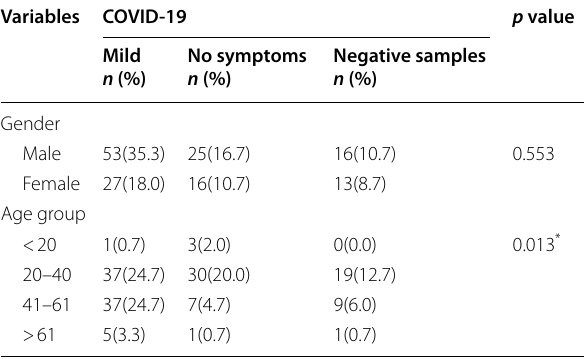
Table 2 Association between gender, age group, and COVID‑19 cases